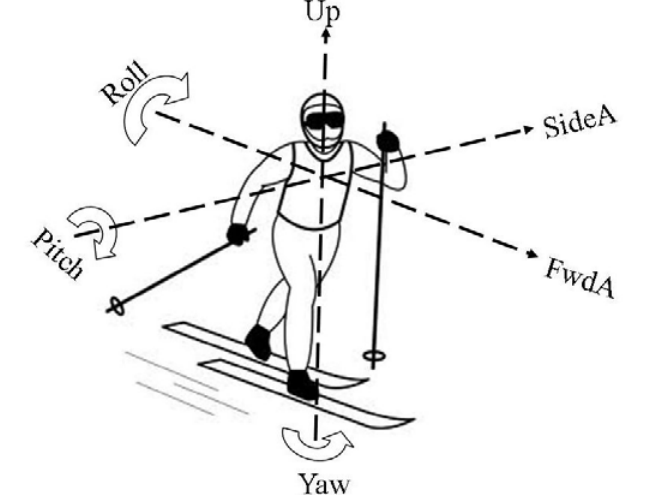
Figure 2. Orientation of accelerometer and gyroscope relative to the